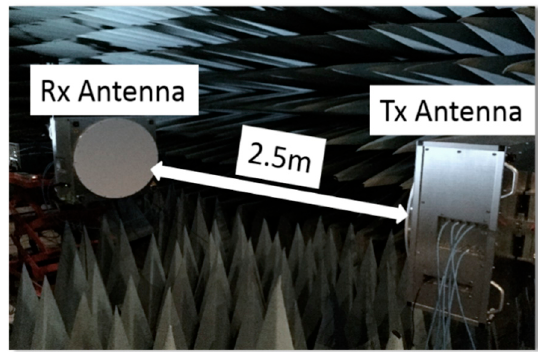
Figure 9. Experimental environment (OAM multiplexing).